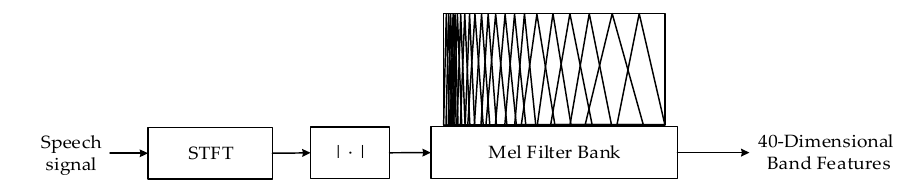
Figure 5. The scheme for extracting Mel-scale sub-band features.